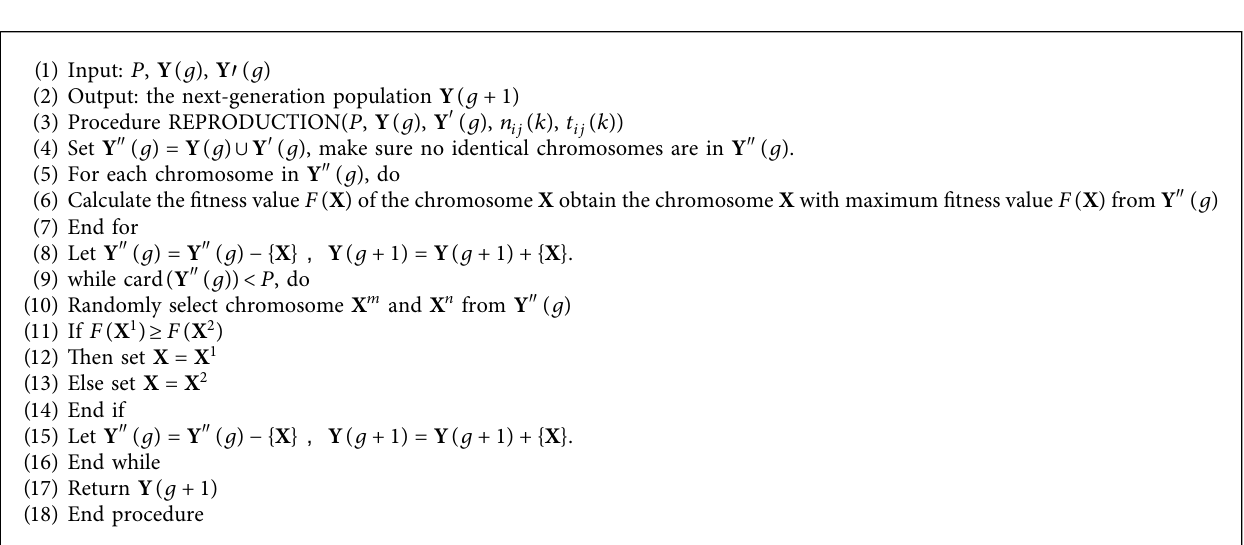
A LGORITHM 3 : Mutation algorithm in genetic algorithm.